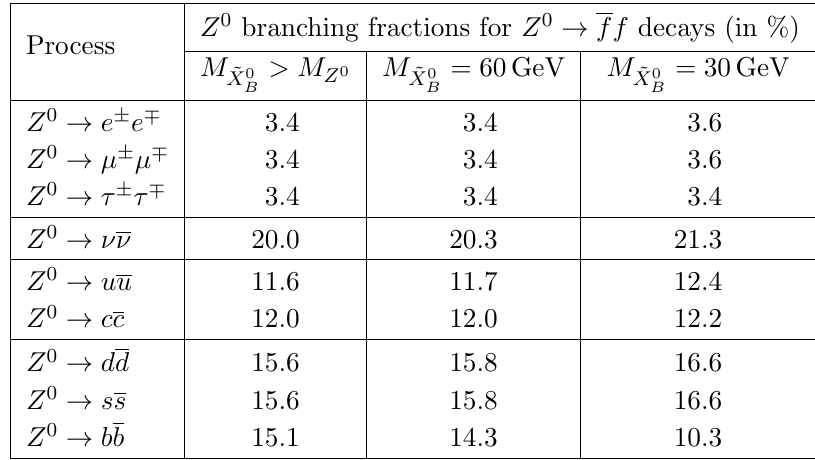
Table 2. Branching fractions for decays of the virtual Z 0 boson for the Z 0 ! ff process for several values of the ~ X 0 mass. The reference values for on-shell Z 0 decays ( M ~ B from the Particle Data Group recommendations